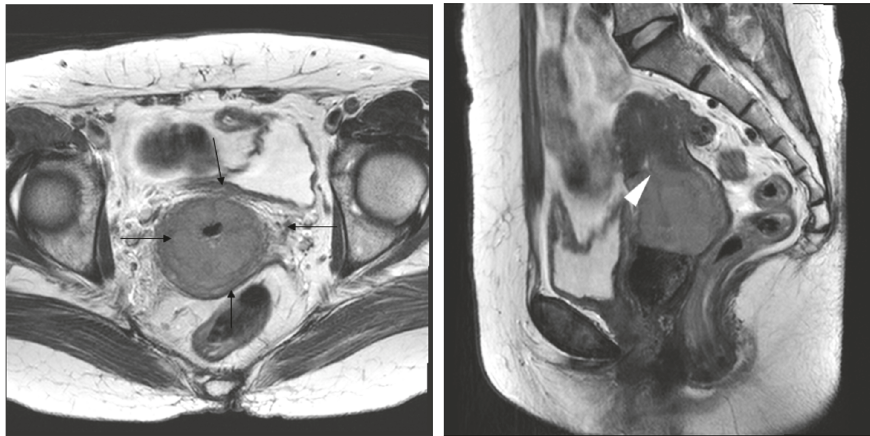
Figure 3: Stage IB2 squamous cervical carcinoma in a 49-year-old woman with radical hysterectomy (A) T2-weighted axial MR images show a 6cm sized lobulated concentric tumoral thickening of whole cervical stroma with an ill-defined peripheral margin (arrow) and invasion to endomyometrium(arrowhead); the maximum diameter of the lesion is measured 6cm on the T2-weighted sagittal image. At histopathological finding, no parametrial lesion was found. MRI stage T2b ( > 4 cm) was overdiagnosed as final pathologic stage